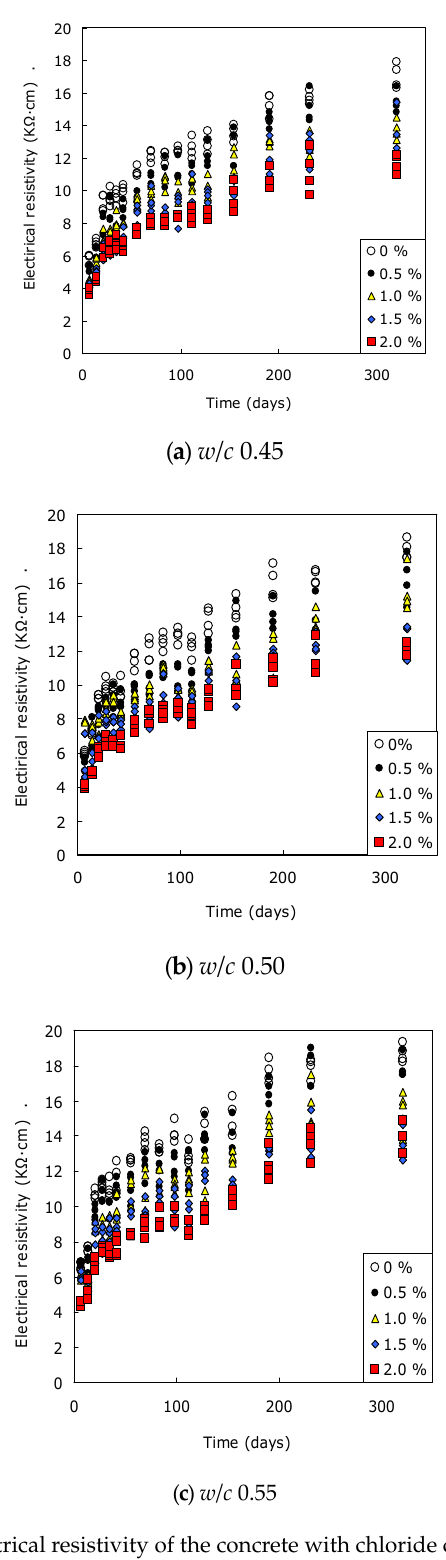
Figure 8. Electrical resistivity of the concrete with chloride concentration.